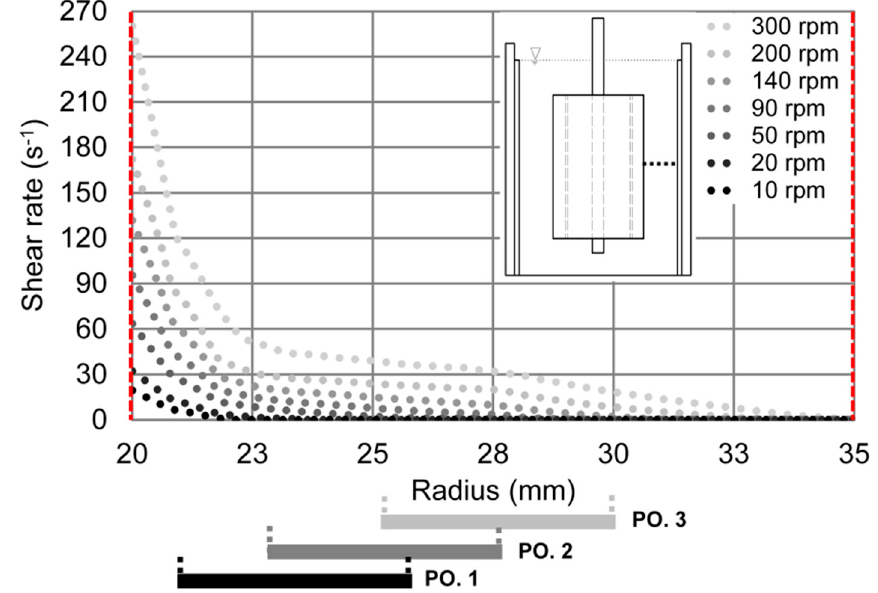
Figure 8. Shear rate distributions from CFD simulations within the gap at the middle height of the